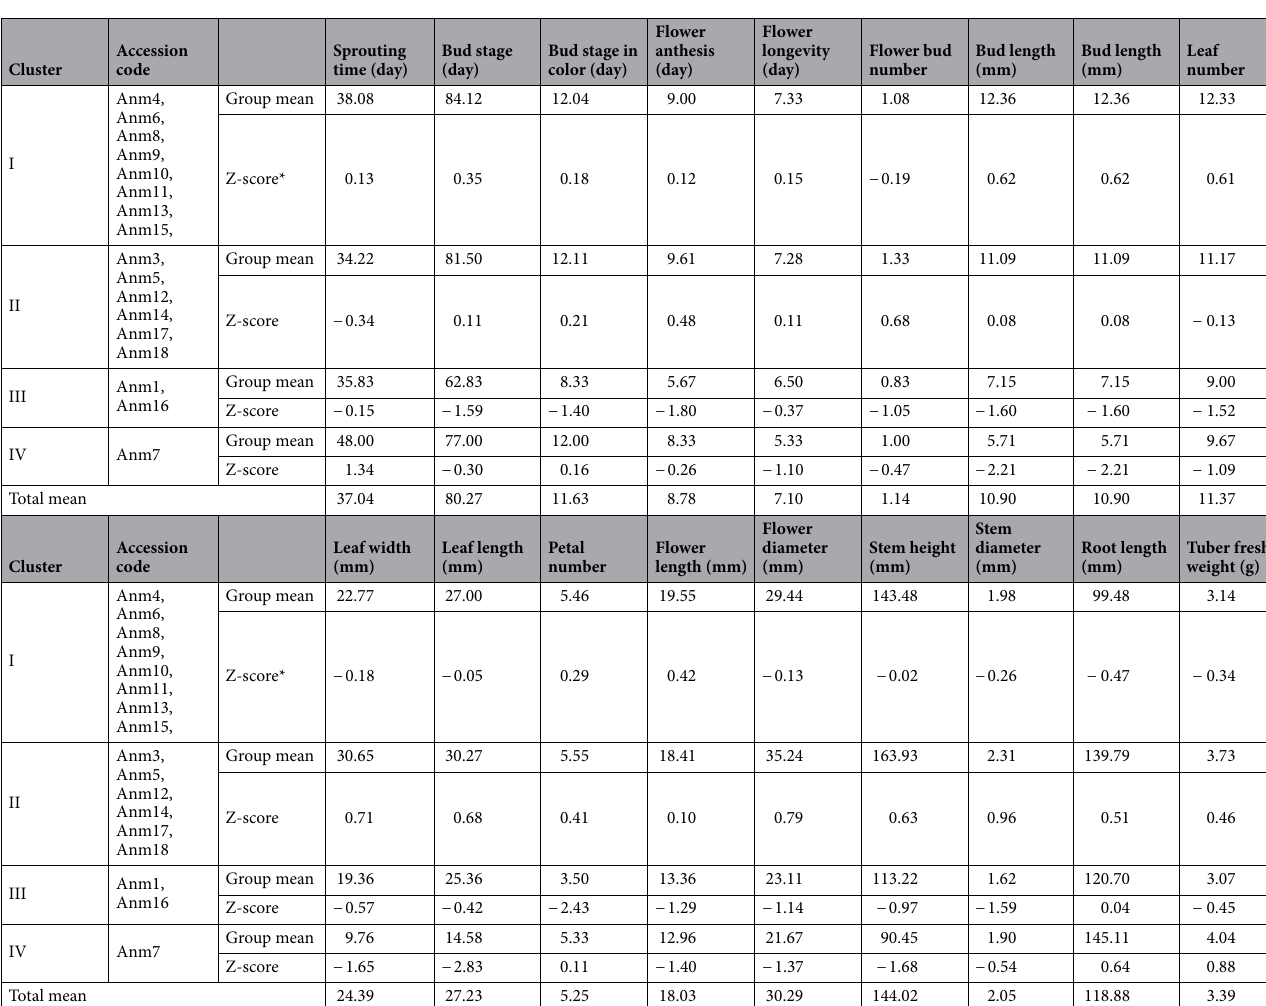
Table 5. Composition of the groups and the distribution of the Anemone accessions in each group based on cluster analysis under chilling pre-treatment. *: Z-score was calculated as the difference between the mean of the trait (for each group) and the total mean, divided by the total standard deviation (SD). The highest positive Z-scores are associated with the relative highest value of the variable among the groups. Since the decrease in the value of phenological traits (except for flower longevity on plant) is a desirable feature, the groups with further negative Z-scores were considered to be more superior. Conversely, since the increase in the value of morphological traits is a desirable feature, the groups with further positive Z-scores were considered to be